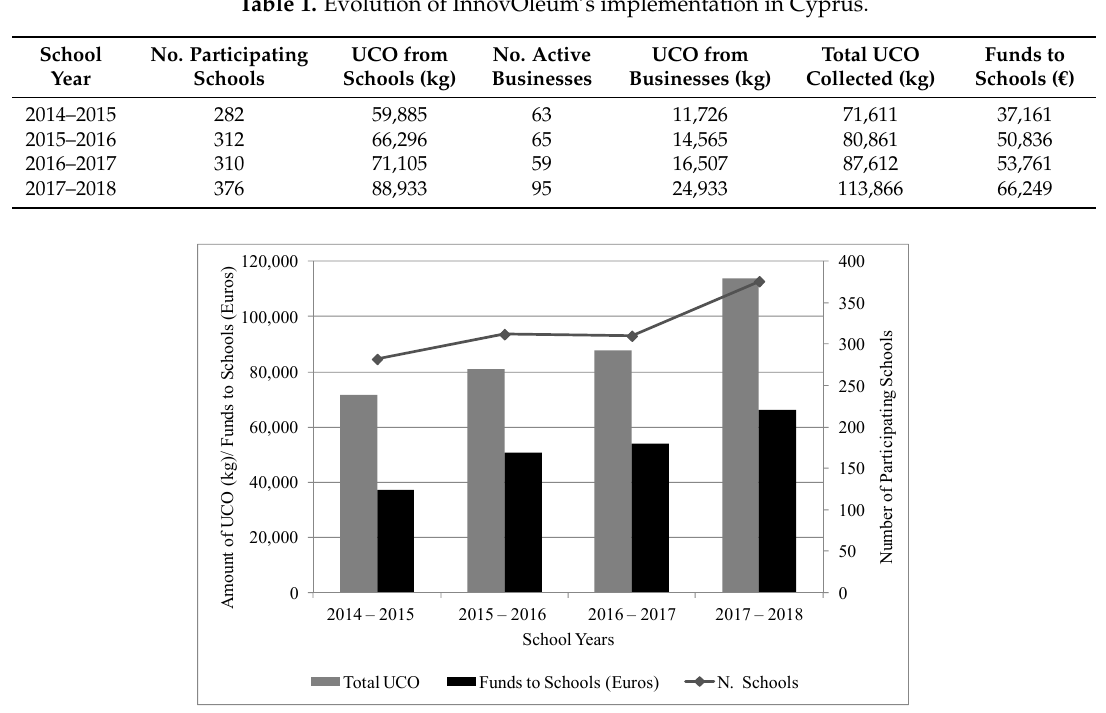
Table 1. Evolution of InnovOleum’s implementation in Cyprus .